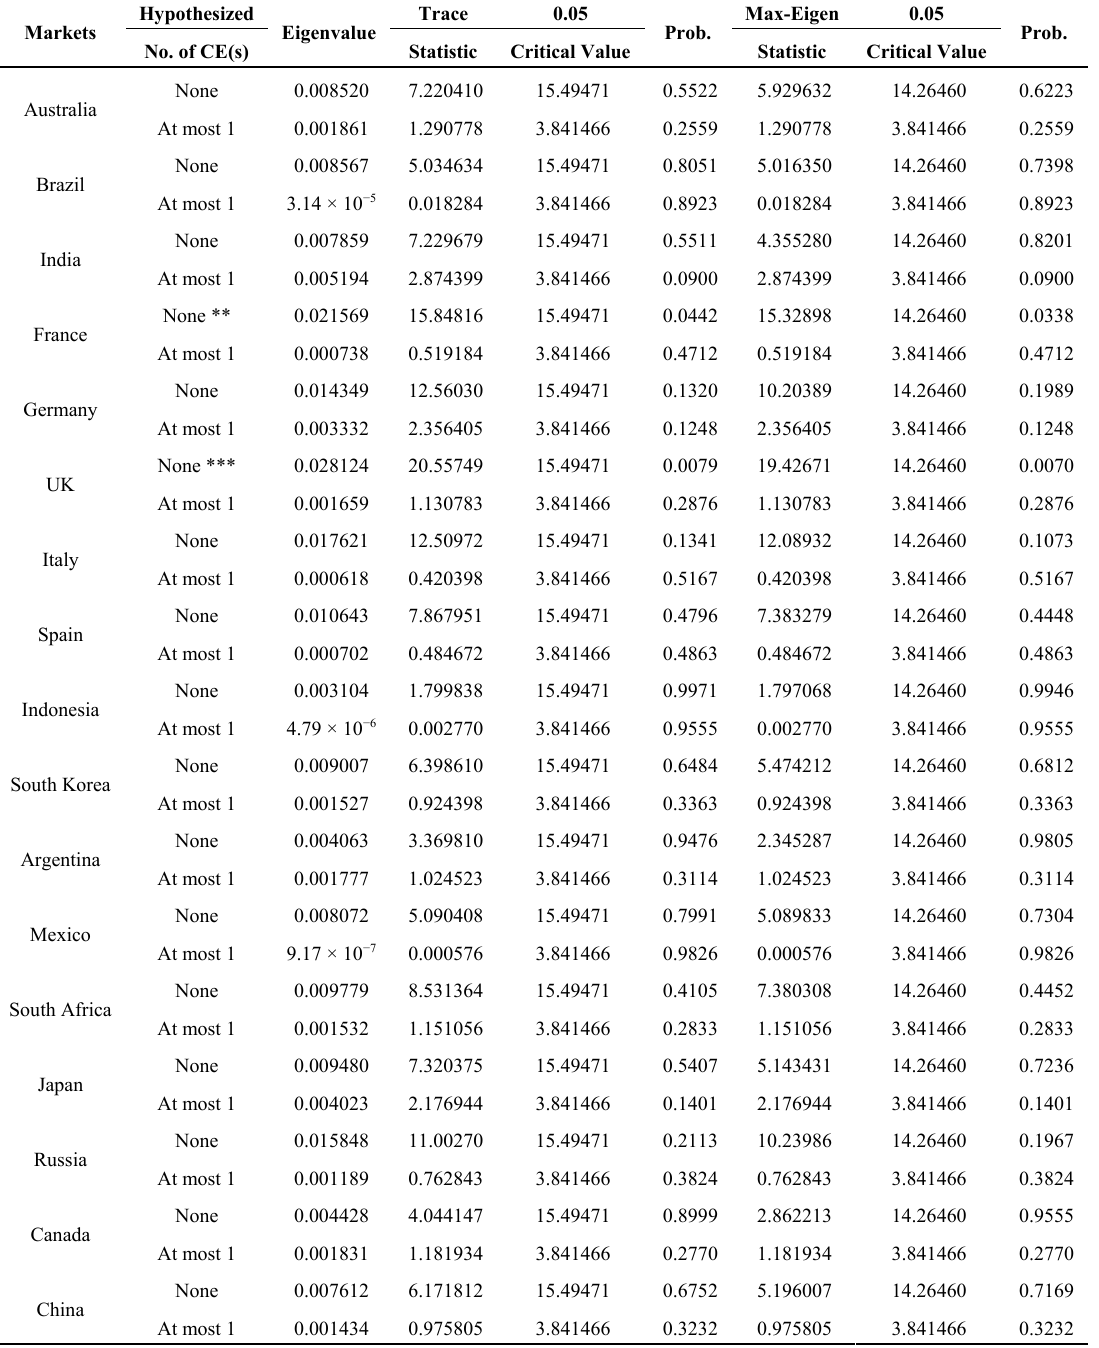
Table A10. Test for Johansen Cointegration in Sub-period